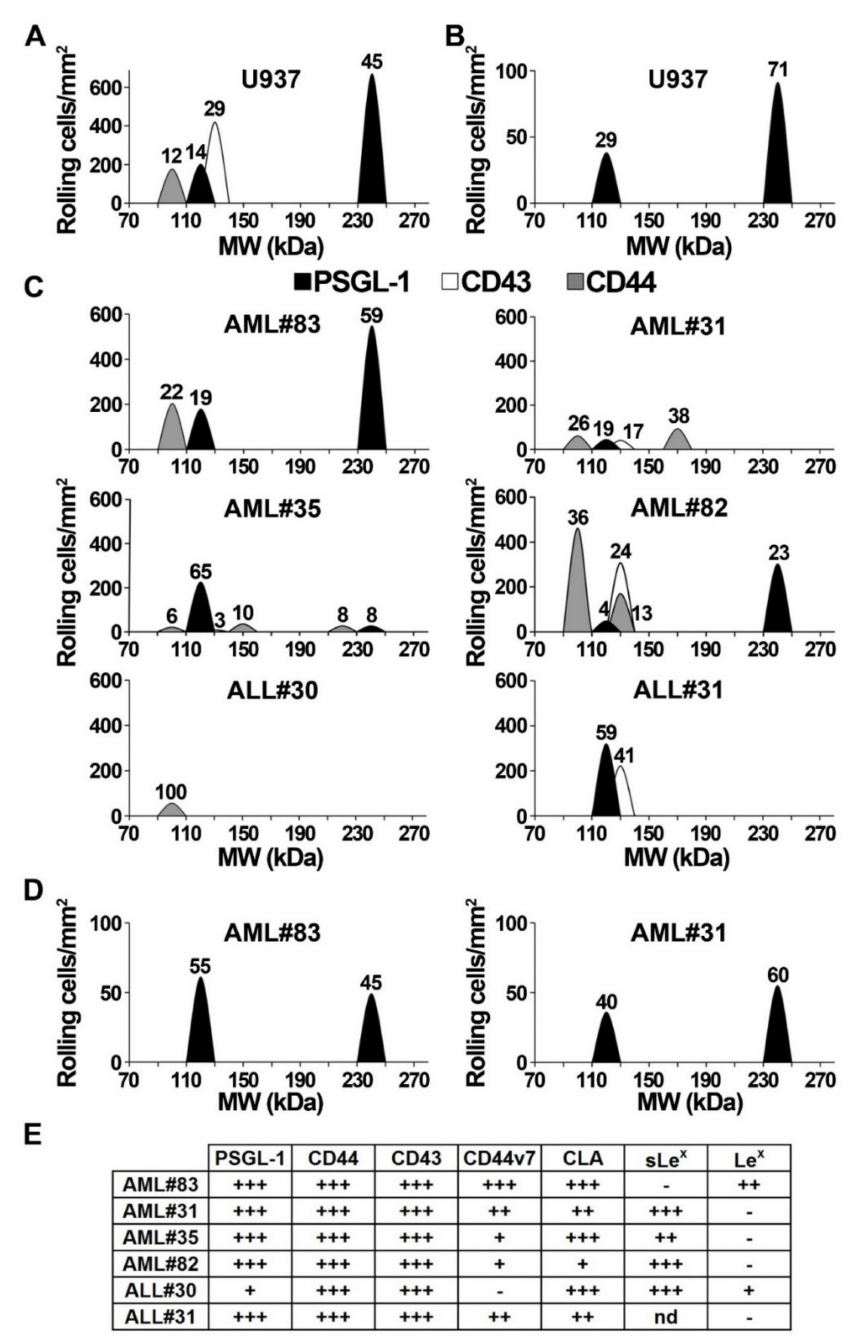
Figure6. P-selectinglycoproteinligand-1(PSGL-1), CD43, andCD44, immunopurifiedfrommyeloblasts orlymphoblastslysates, supportE-orP-selectin-dependentrollingtovariousextents. PSGL-1, CD43and CD44 were immunoprecipitated from U937 cell lysates ( A , B ) or blasts lysates from patients with acute myeloid leukemia (AML) (AML #83, #31, #35, #82) or ALL (ALL #30, #31) ( C , D ), separated by sodium dodecyl sulfate–polyacrylamide gel electrophoresis (SDS-PAGE) and transferred on polyvinylidene fluoride (PVDF) membranes onto which K562-E-selectin cells ( A , C ) or Chinese hamster ovary-P-selectin (CHO-P) cells ( B , D ) were perfused at 1.0 dyne / cm 2 to monitor selectin-dependent interactions. Cell displacements were video-recorded and recruitment was assessed in 16 microscopic fields of 0.26 mm 2 . The number of rolling cell / mm 2 was tabulated as a function of molecular weight and the mean rolling cell numbers on PSGL-1, CD43 or CD44 were represented by histograms. Data are representative of